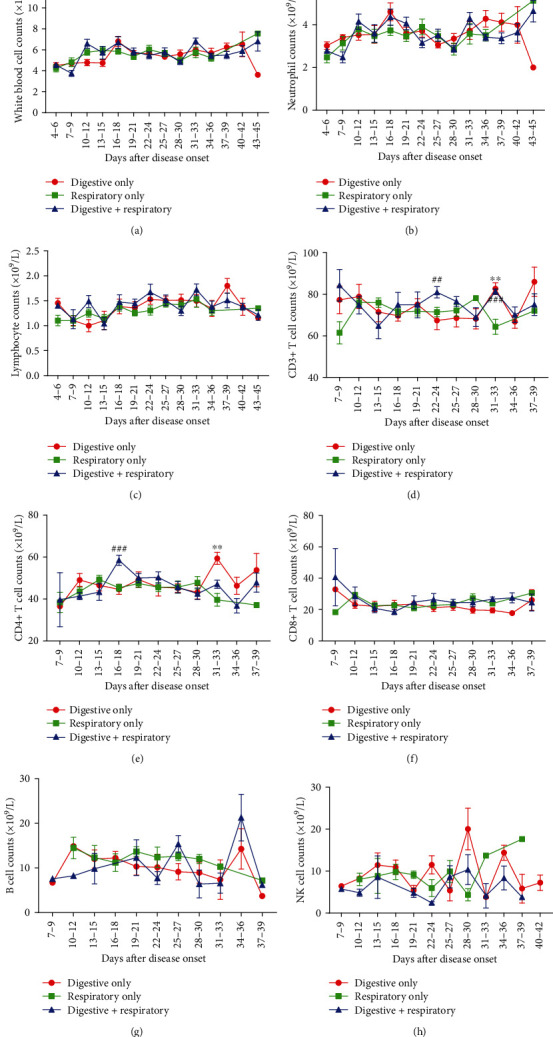
Dynamic profile of peripheral immune cell subsets in COVID-19 patients with different symptoms. Timeline charts illustrate the peripheral WBCs (a), neutrophils (b), lymphocytes (c), CD3+ T cell (d), CD4+ T cell (e), CD8+ T cell (f), B cell (g), and NK cell (h). Error bars, mean ± SEM; ∗∗P < 0.01, Digestive Only vs. Respiratory Only. ##P < 0.01, ###P < 0.001, Digestive+Respiratory vs. Respiratory Only.